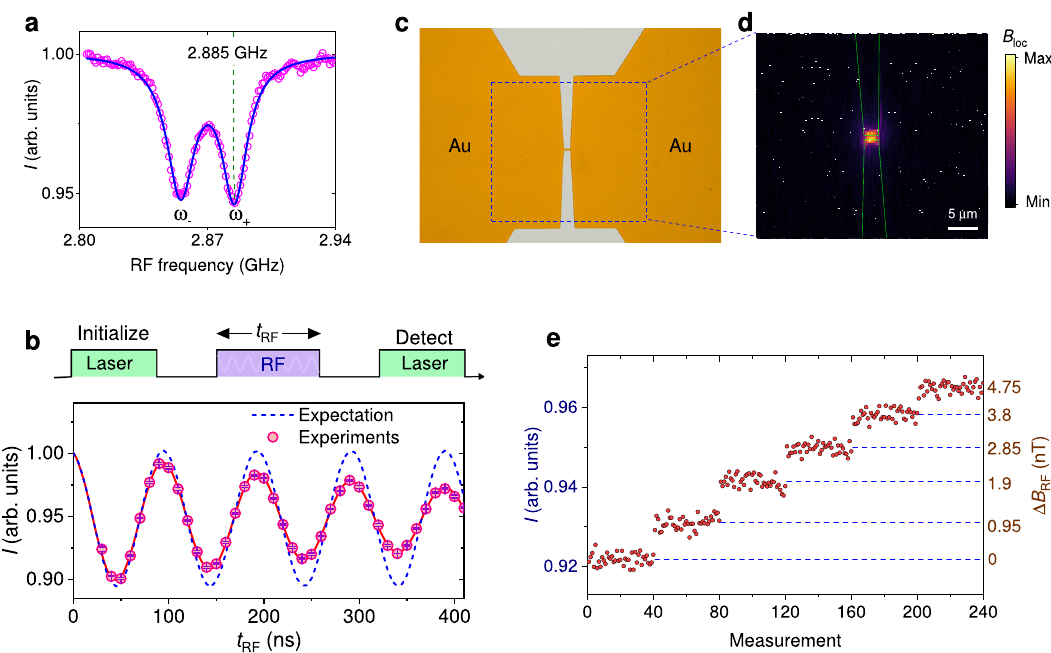
Fig. 2 | The quantum sensing of free space RF signal. a Optically detected mag- standard error of measurements. c The photograph illustrated the center of netic resonance (ODMR) spectrum of NV center ensemble. The circles are experi- nanowire-bowtie structure. d The distribution of RF fi eld, which is imaged by mentalresults.ThesolidlineistheLorentz fi t. b TheRabioscillationisvisualizedby detecting the spin state transition under continuous-wave RF and laser excitation. e Real time measurement of RF amplitude modulation with NV center ensemble. initialization and detecting the spin state with a green laser (0.7mW power). The (= 550 ns) for both the initializing and detecting. The dashed pulse duration is t det The amplitude of RF source is changed with a step of 0.95 nT. Each experimental 2 line indicates a perfect spin transition without decoherence and inhomogeneous datapointisobtainedbyrepeatingthespindetectionpulsesequence2×10 5 times. Only the reference RF is turned on here, and the power is approximately 2.3 broadening. High fl uorescence emission means the spin state of m s =0, while low emission rate represents the spin state of m s =±1. The error bars represent the